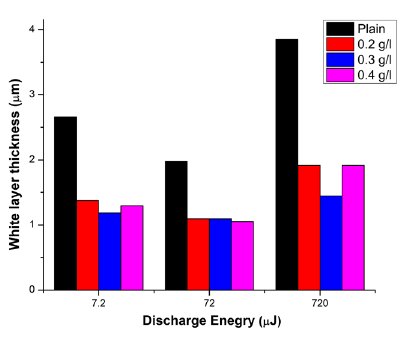
Figure 8. Effect of SiC concentration and discharge energy on